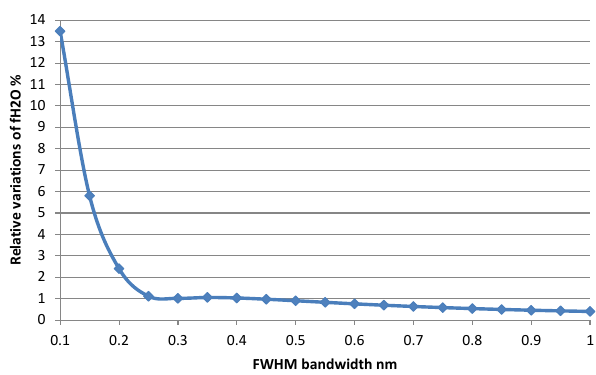
Fig. 9. Optical layout of the polychromator: L1-L2 – spherical lens = collimator (f/2.39, F = 165 mm), REF – Raman edge filter, DG – 2 O holographic diffraction grating (3600 mm − 1 , 85×85 mm 2 ) , M – parabolic mirror (f/4, F = 445 mm), PMT – photomultiplier tubes.